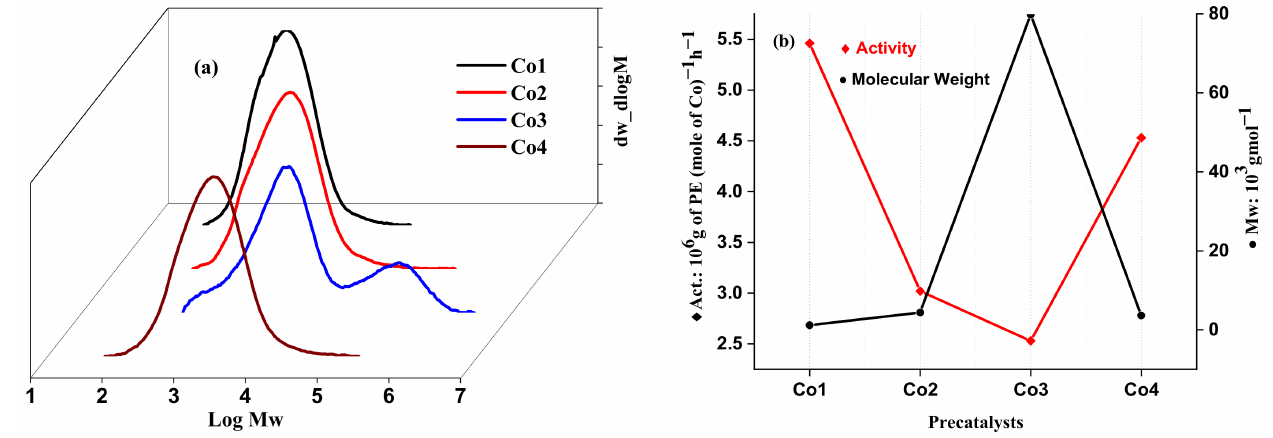
Figure 10. GPC curves of the obtained polyethylene ( a ); activity and M w for different precatalysts at the optimized reaction conditions ( b ) for the Co1 – Co4 /MMAO system (Table 4, entries